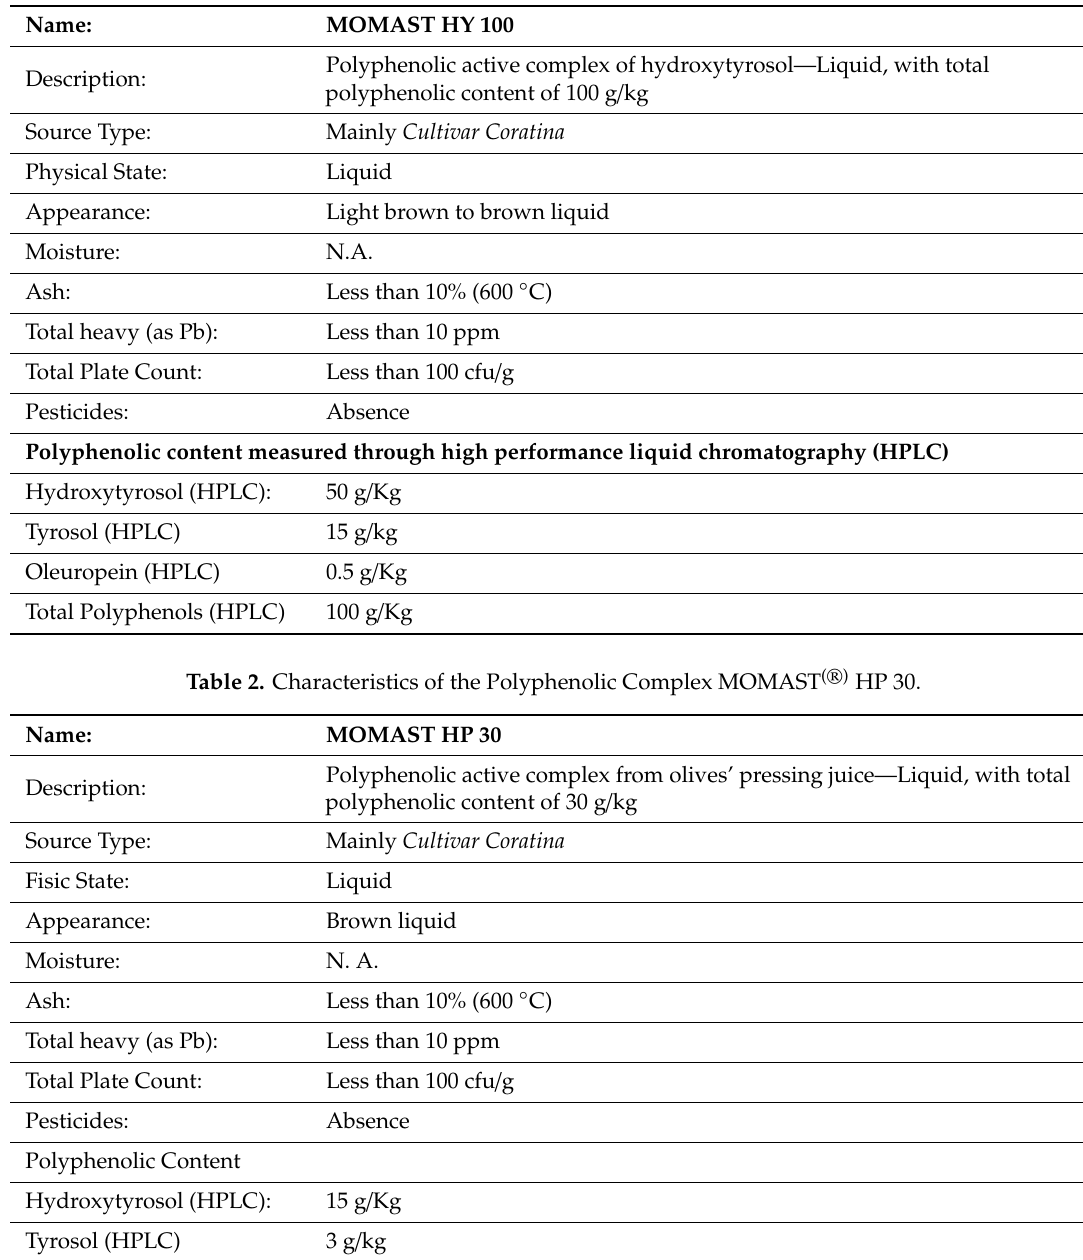
Table 1. Characteristics of the polyphenolic complex MOMAST ( ® ) HY 100.